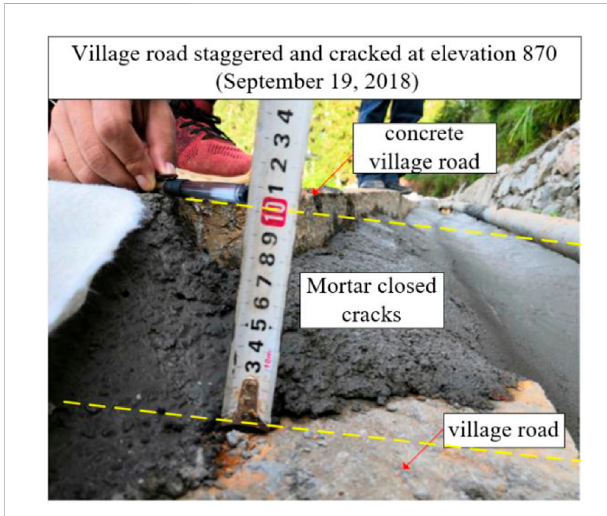
FIGURE 5 Deformation signs in the middle part entering the dry season.